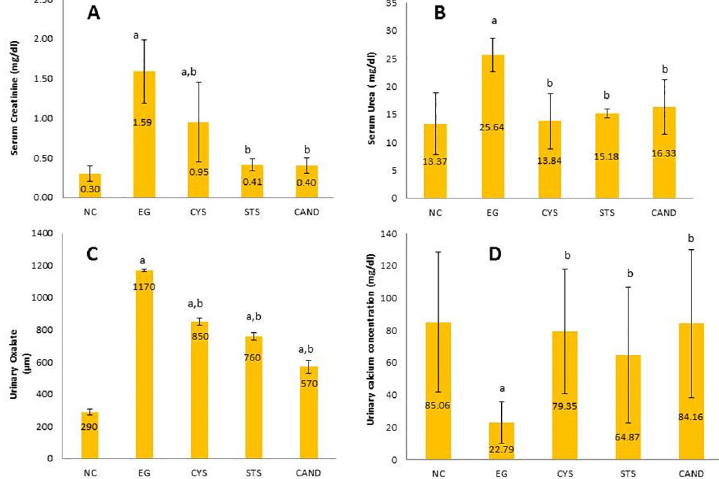
Fig 2. Effect of CYS, STS, CAND treatments on: (A) Serum creatinine (B) Serum urea (C) Urinary Oxalate (D) Urinary calcium concentration. Data are represented as a mean ± SD (n = 20/group), significance was set at p < 0.05; a: Significant vs NC group, b: Significant vs EG control group. NC group: Rats received water; EG group: (1% ethylene glycol in drinking water for 28 days); CYS group: (EG + 750 mg/kg CYS, orally, once daily); STS group: (EG + 0.4 g/kg STS, i.p., 3 times/week); CAND group: (EG + 70 μ g/mL CAND in drinking water). Treatments were administered simultaneously with EG drinking water for 28 days.